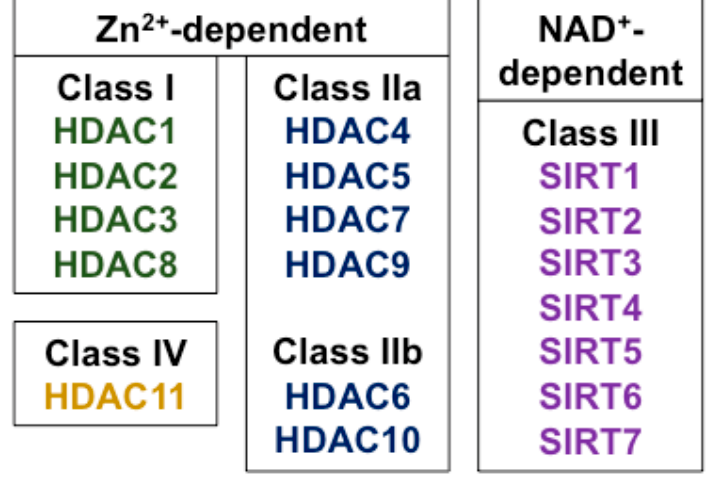
Figure 1. Classes of histone deacetylase (HDAC) enzymes in humans.